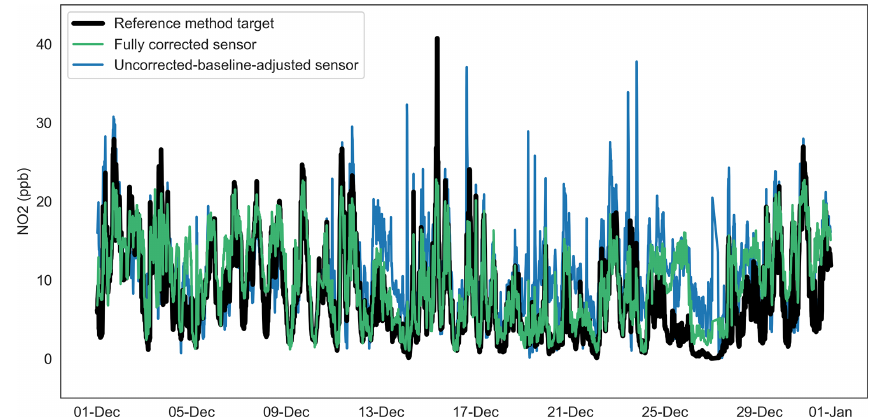
Figure 12. Time series of uncorrected-baseline-adjusted sensor, fully corrected sensor and reference method observations for NO 2 at Oxford St Ebbe’s (unseen data) for December 2020. Table 5. RFR correction model performance in terms of the MAE relative to reference method observations (unseen data) for December 2020. Mean absolute error (MAE) Change in the MAE arising from Baseline Fully corrected full RFR correction corrected (baseline + RFR correction) NO 2 (ppb)